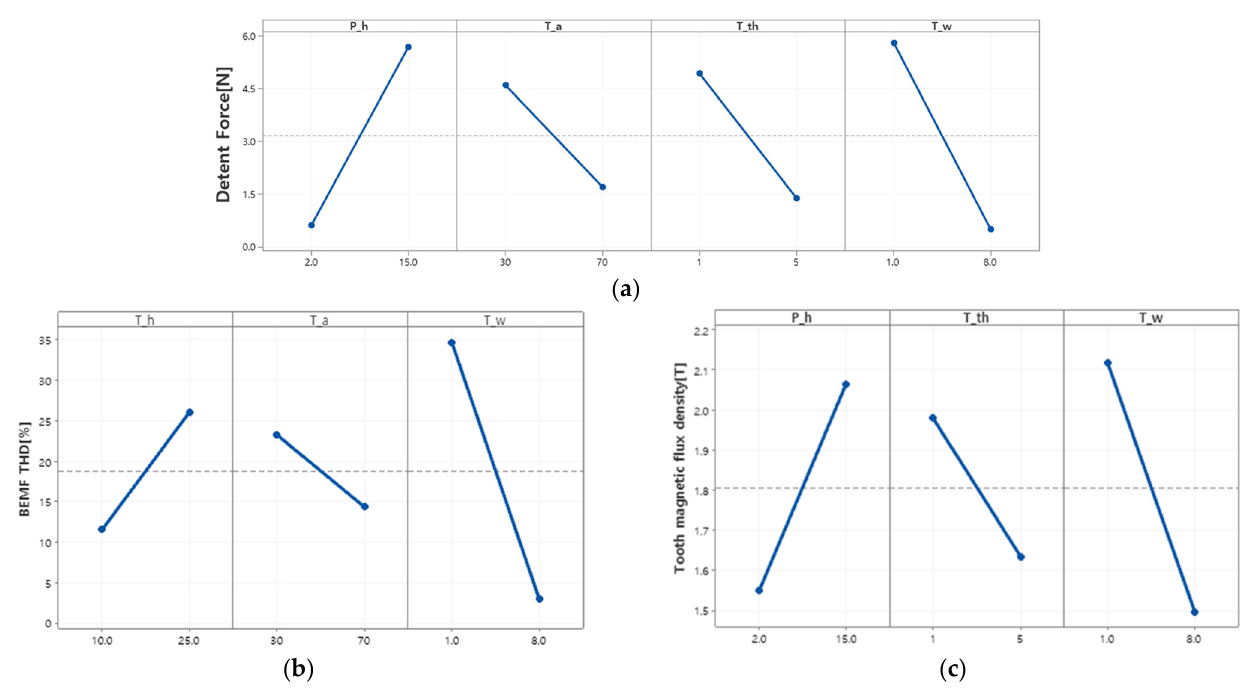
Figure 8. Main effects plot for objective functions obtained from the fractional factorial design: ( a ) Detent force; ( b ) Back EMF; ( c ) Magnetic flux density.